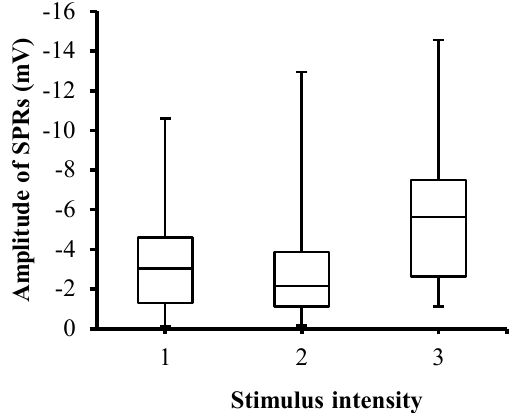
Fig. 2: Box-plot with medians, quartiles and the min and max as whiskers shows value of SPRs_Amp with respect to the stimulus intensity.